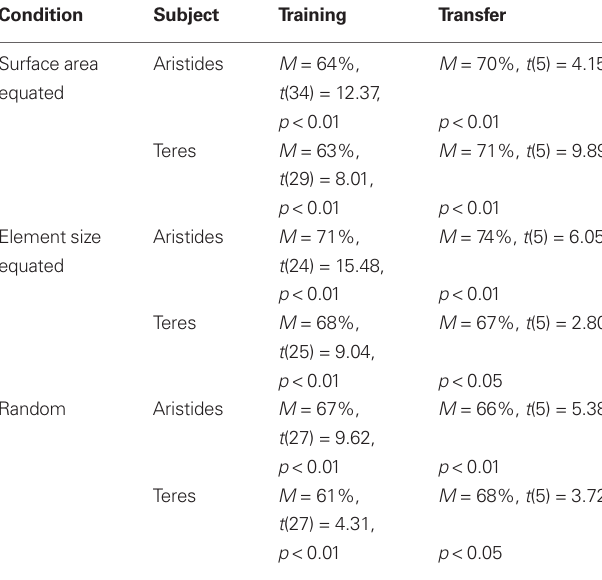
Table 1 | Accuracy during three stimulus control conditions in experiment